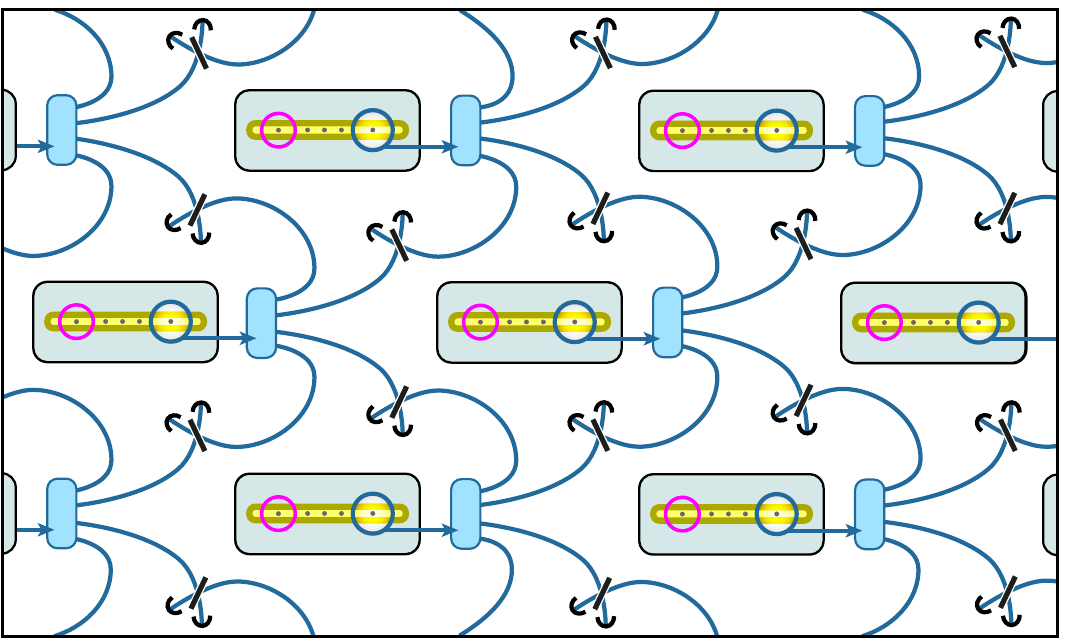
FIG. 10. Four cells of the design shown in Fig. 5(b) with the connections achieved by optical switching. Note that the ion trap elements in this figure could equivalently be any other few-qubit, optically active system such as a NV center in diamond. The system shown here is equivalent to that shown in Fig. 11, which has more complex cells and dedicated (nonswitched) cell-cell links; those features increase the speed, but the error thresholds are the same.